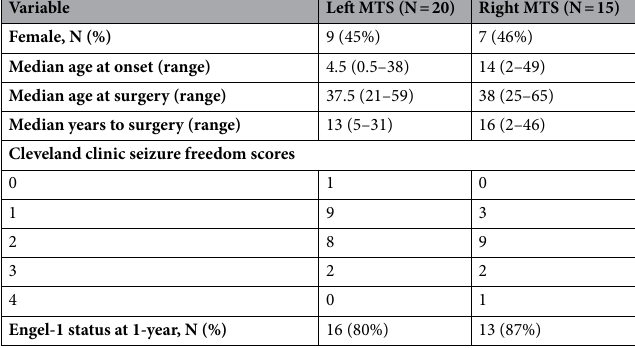
Table 1. Baseline and postoperative parameters of subjects analyzed in study.